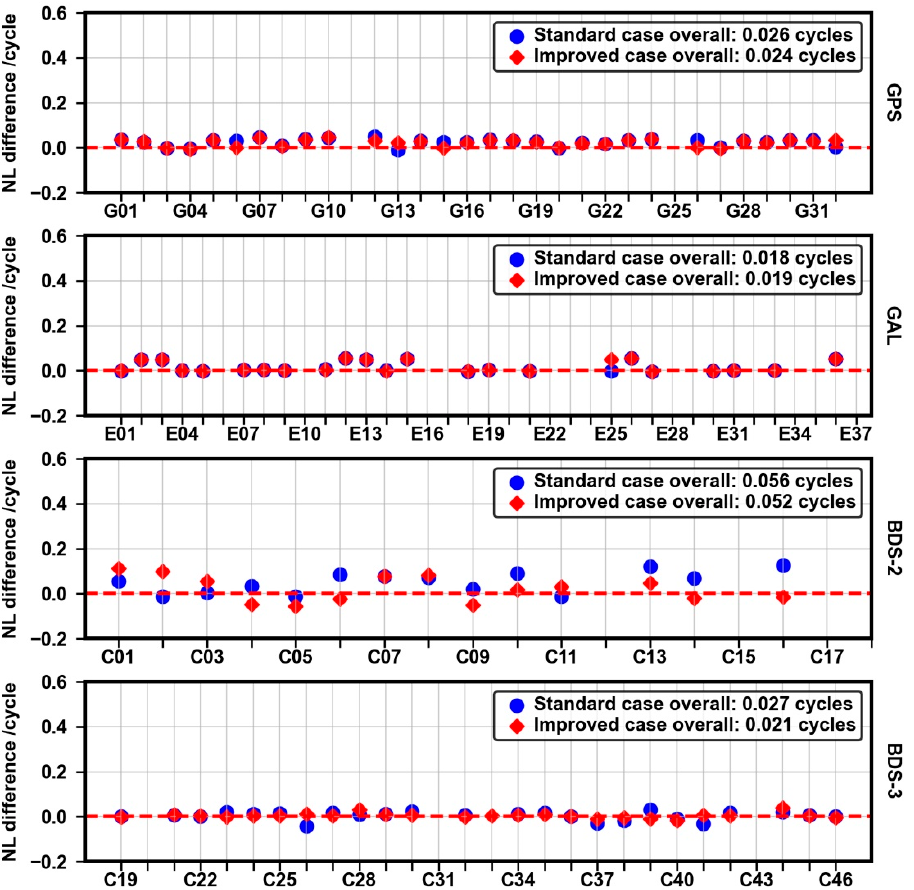
Figure 16. NL phase bias differences of Case 4 relative to Case 1 for the standard case and improved case.